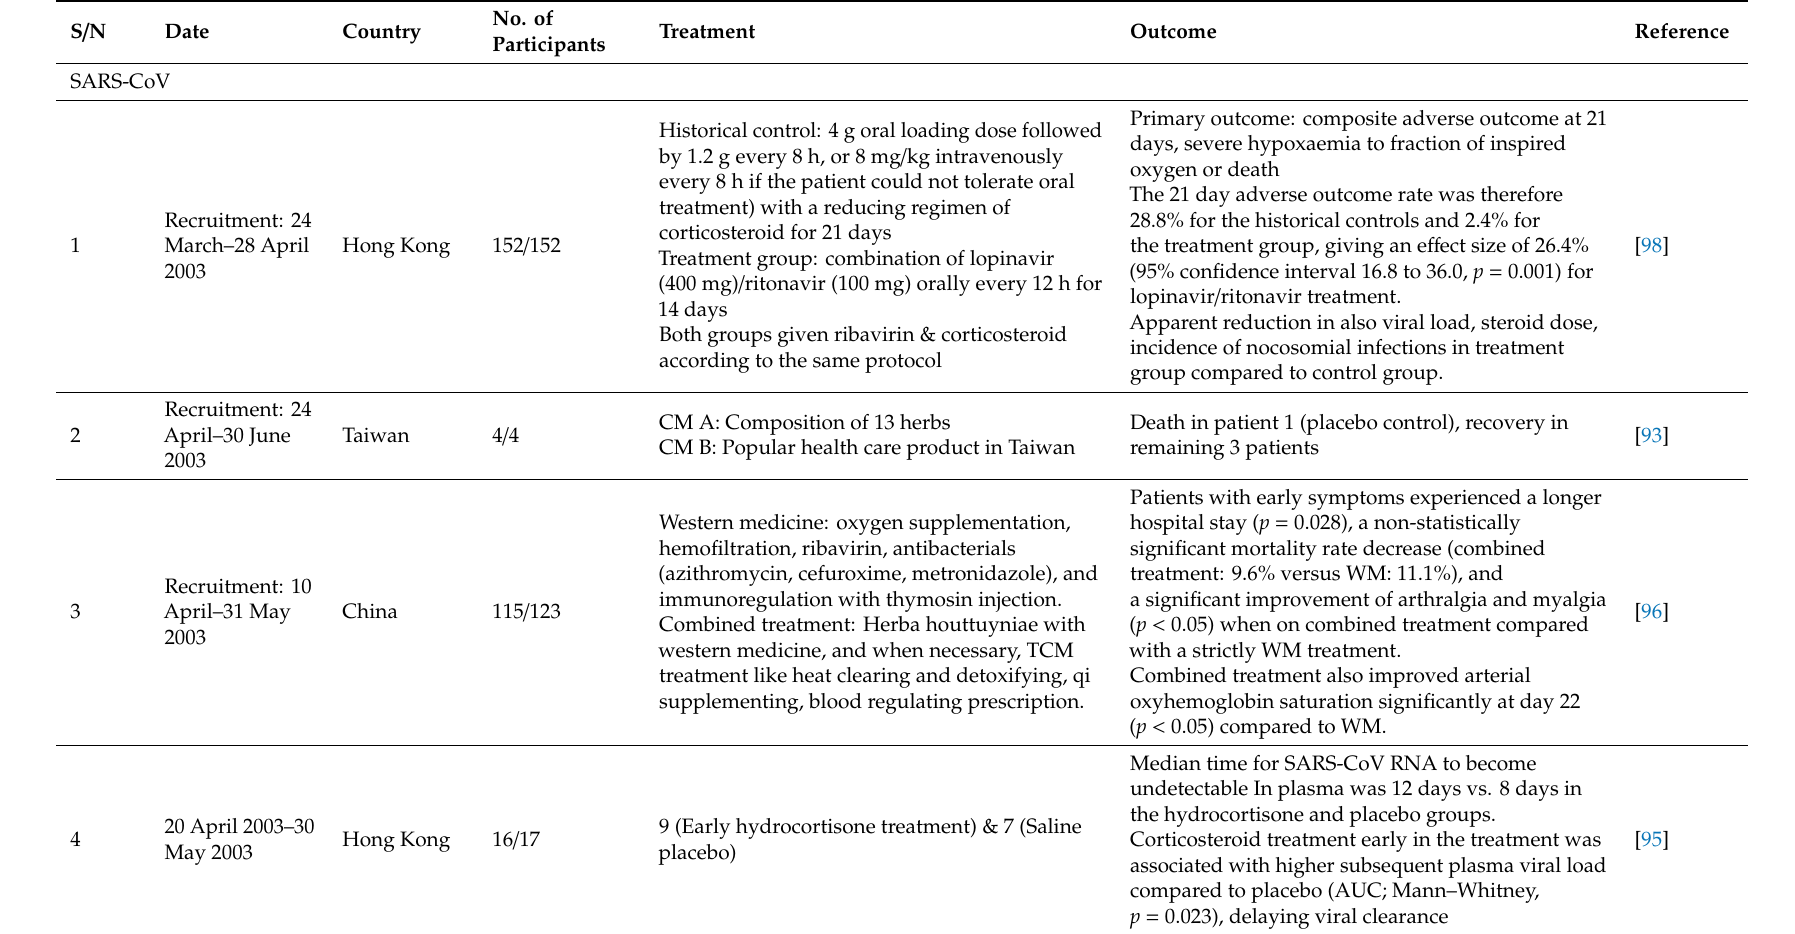
Table 6. Completed Randomized Controlled Trials for SARS-CoV & MERS-CoV